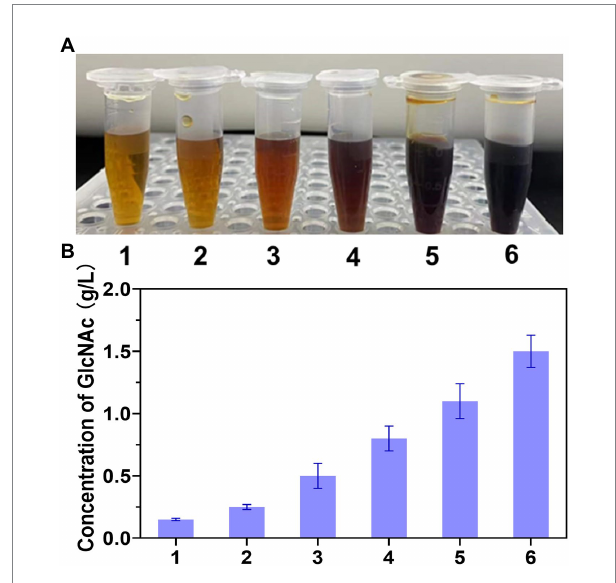
FIGURE 1 The degradation efficiency of different chitinase combinations. (A) Different reaction solutions treated by DNS colorimetry. (B) The concentration of GlcNAc under the degradation of different chitinase; (1: Chitinase Sm ChiC from Serratia marcescens ; 2: Chitinase Sp ChiA from proteamaculans NJ303, 3: Combination of chitinase Sm ChiC and NAGasA from Chitinolyticbacter Sp. GC72, 4: Combination of chitinase Sp ChiA and NAGasA, 5: Combination of chitinase SmChiC and Cm NAGase from Chitinolyticbacter meiyuanensis SYBC-H1, 6: Combination of chitinase Sp ChiA and Cm NAGase).